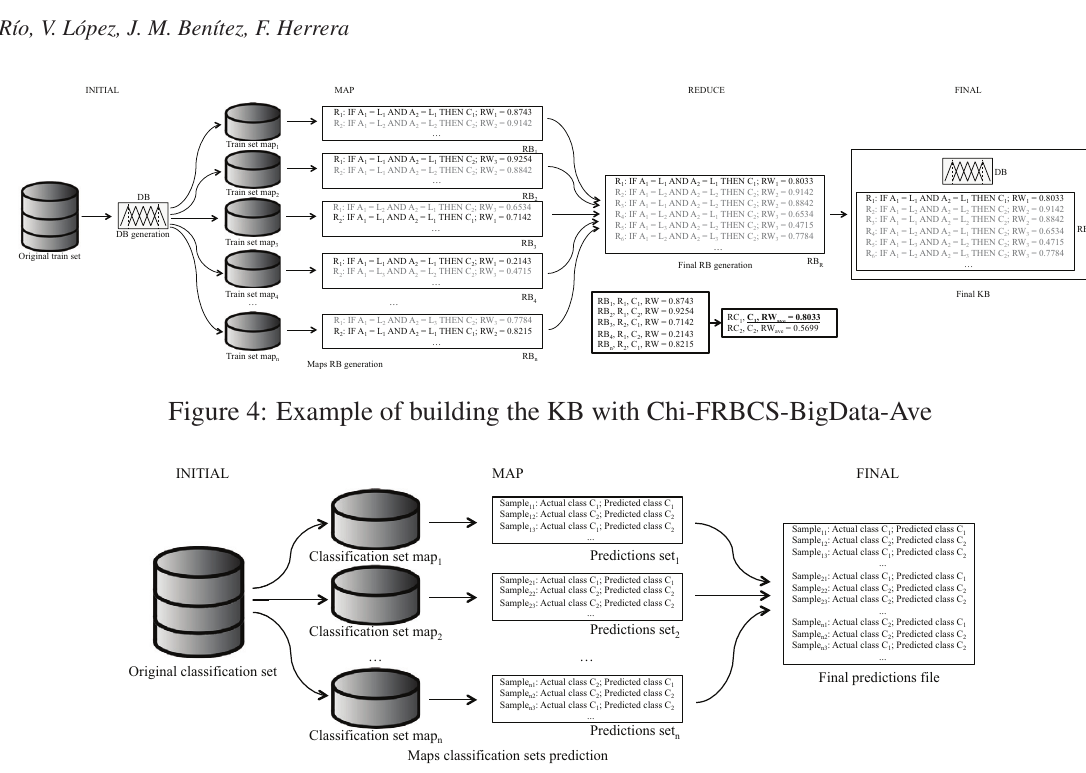
Figure 5: A flowchart of how the classification of a big dataset is organized in Chi-FRBCS-BigData the examples that belong to big data classification sets using the KB built in the previous step.